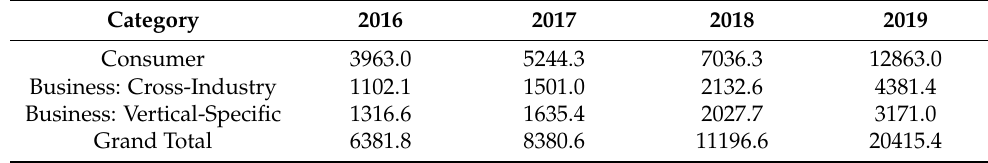
Table 1. IoT units installed by categories (millions of